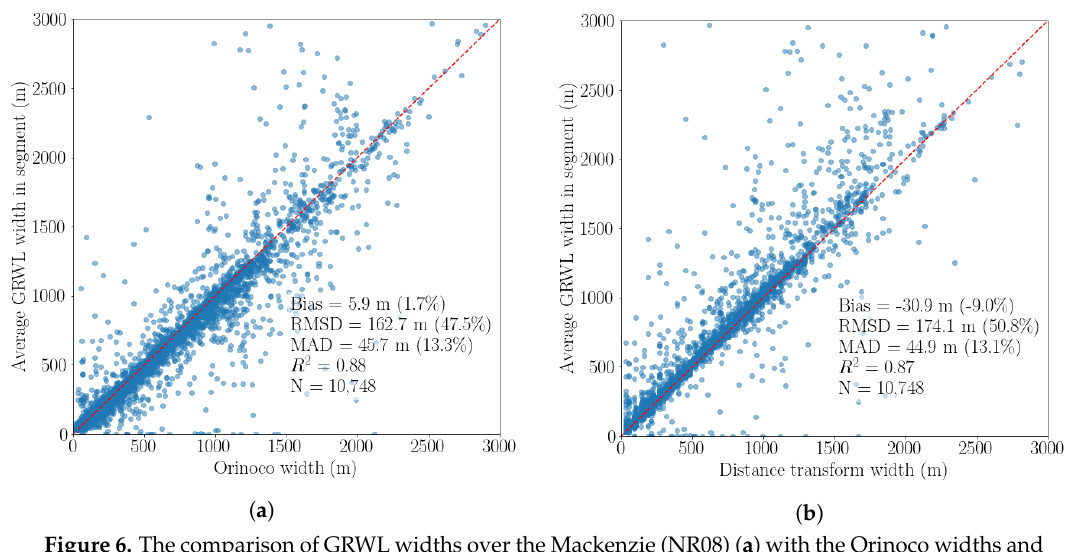
Figure 6. The comparison of GRWL widths over the Mackenzie (NR08) ( a ) with the Orinoco widths and ( b ) with widths derived using the distance transform. We have removed segments whose corresponding nodes are junctions or are adjacent to them. The deviation statistics are computed subtracting the values of the estimated width ( x -axis) from the GRWL segment-level width ( y -axis). The percent error statistics (%) are relative to the mean GRWL widths ( y